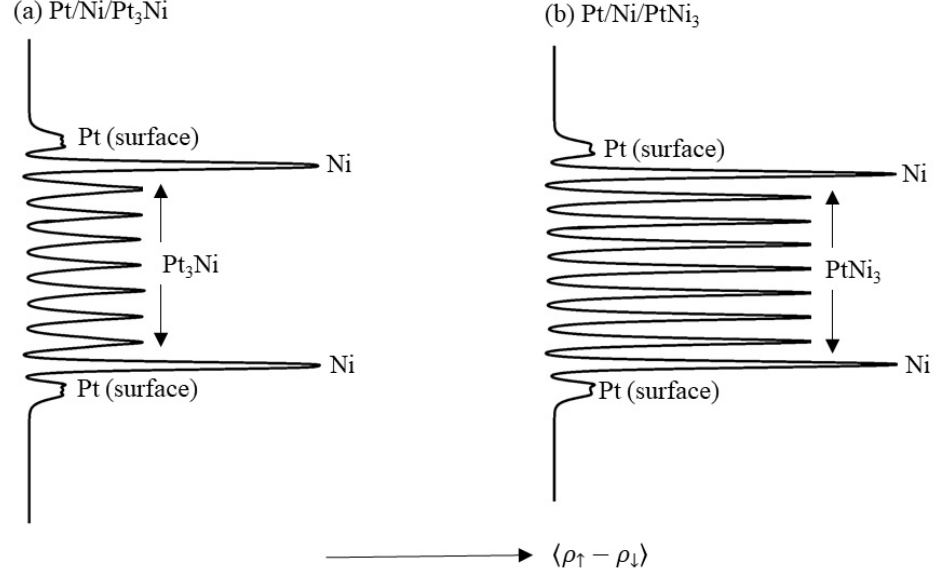
Figure 13. Average spin density ρ ↑ − ρ ↓ of the surfaces of unreacted ( a ) (111)-Pt/Ni/Pt 3 Ni and ( b ) (111)-Pt/Ni/PtNi 3 . The averaging was performed parallel to the (111) plane. The labels show the regions of bulk Pt 3 Ni and PtNi 3 , selvedge Ni and surface Pt in symmetric slabs, which each have 11 atomic layers in total.